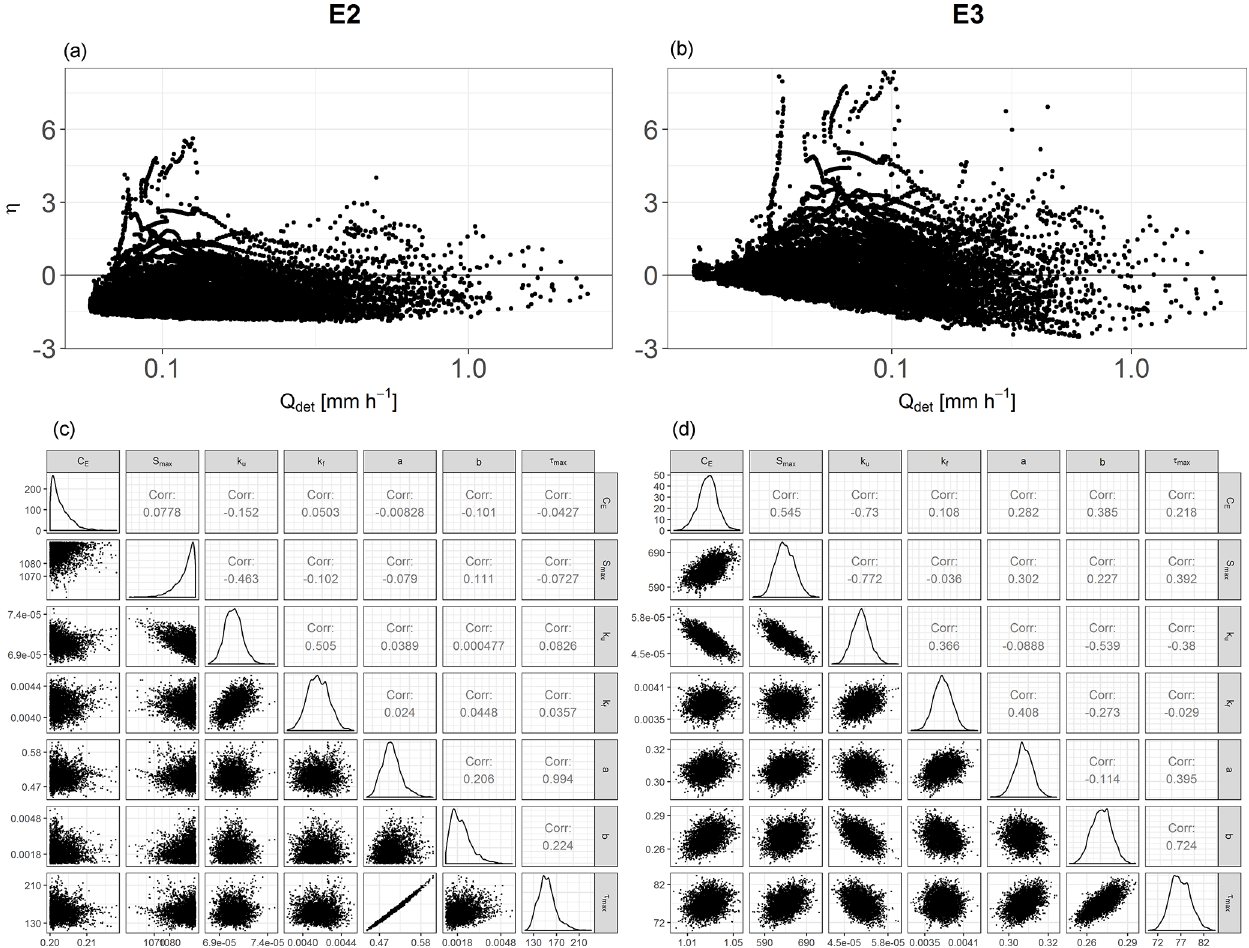
Figure 6. Transformed residuals, η , as a function of modelled streamflow (a, b) and correlation structure of the posterior parameter sample (c, d) resulting with error models E2 (a, c) and E3 (b, d) for data with hourly resolution in the Murg